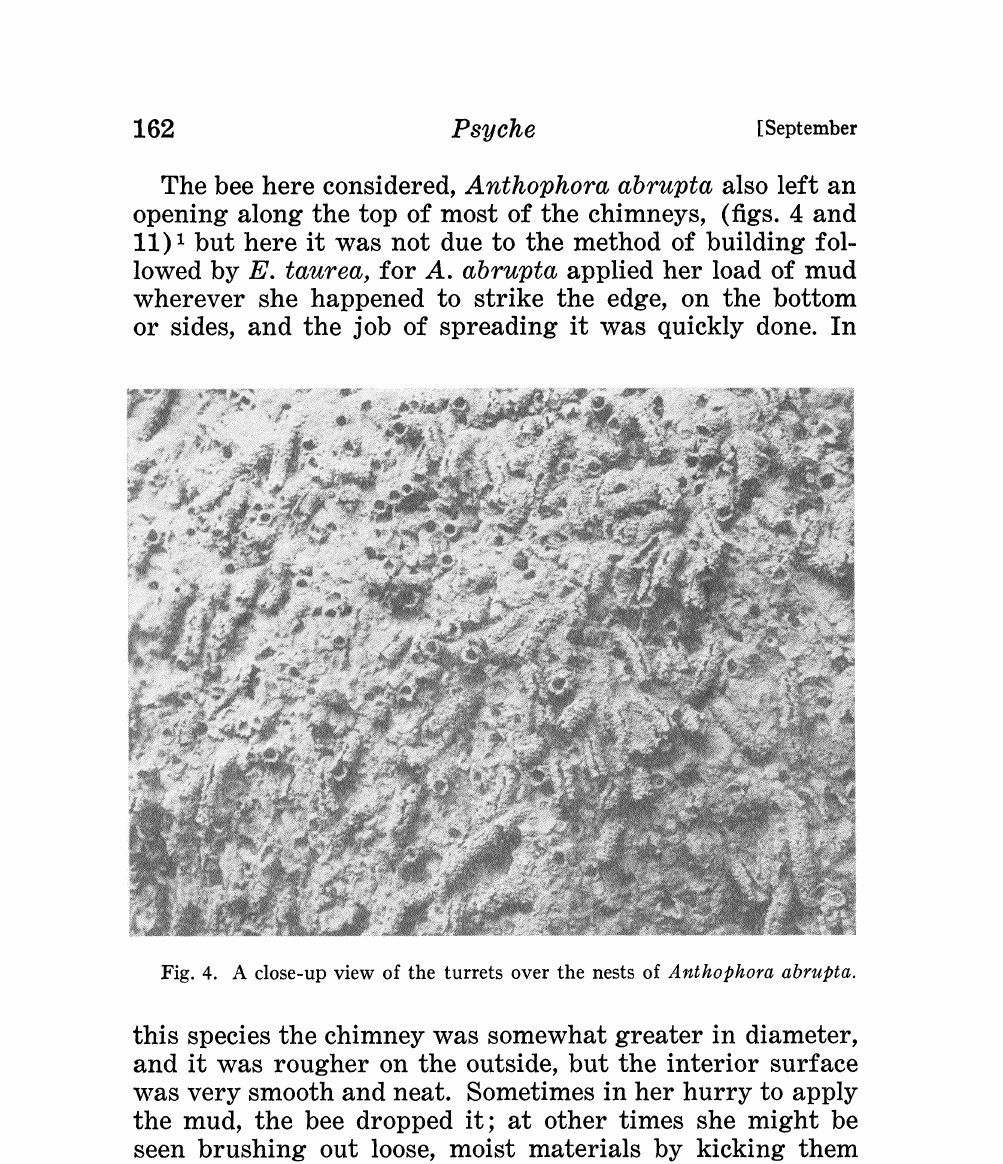
Fig. 4. A close-up view of the turrets over the nests of Anthophora